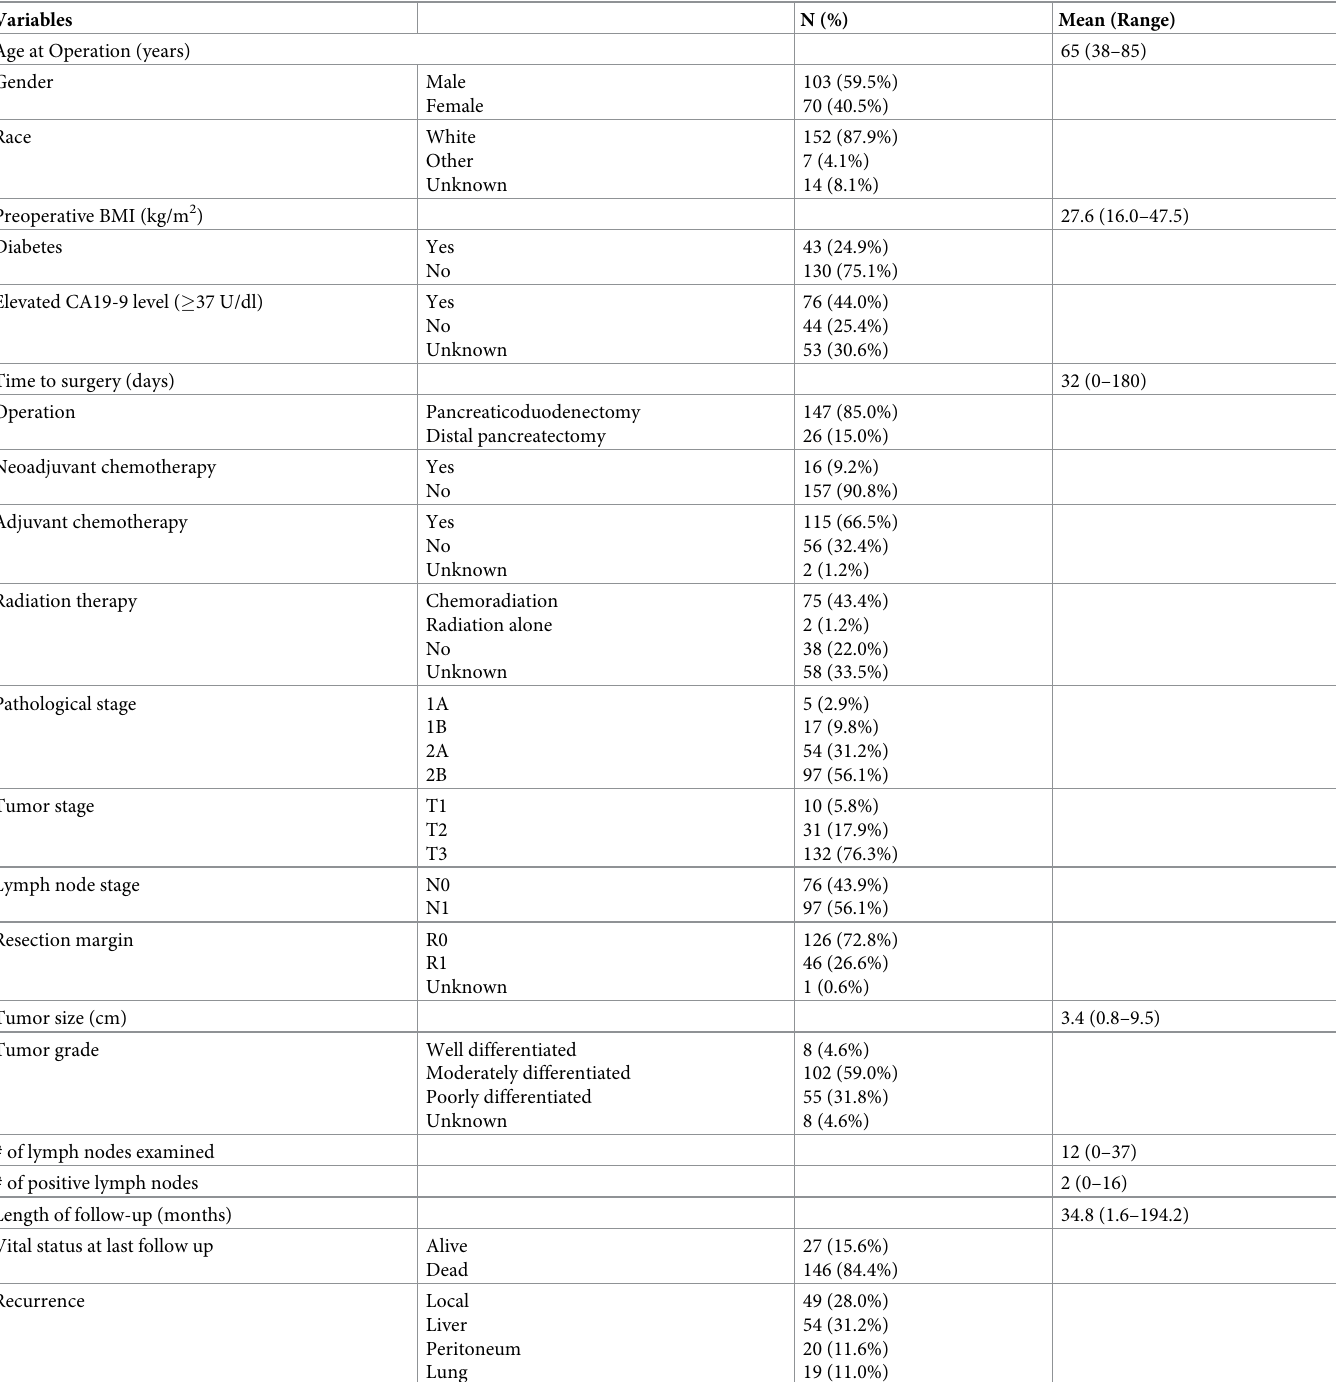
Table 1. Patients’ demographics and clinicopathological